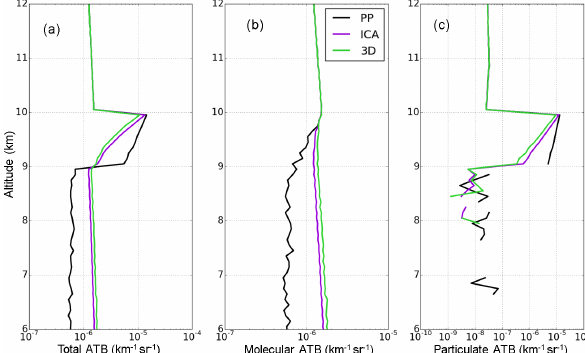
Figure 13. Vertical profiles of (a) total, (b) molecular, and (c) par- ticulate ATB simulated by McRALI. The cloud is located between 9 and 10km. Black lines represent simulations using the PP cloud model, purple lines the ICA cloud model, and green lines the 3D box-cloud